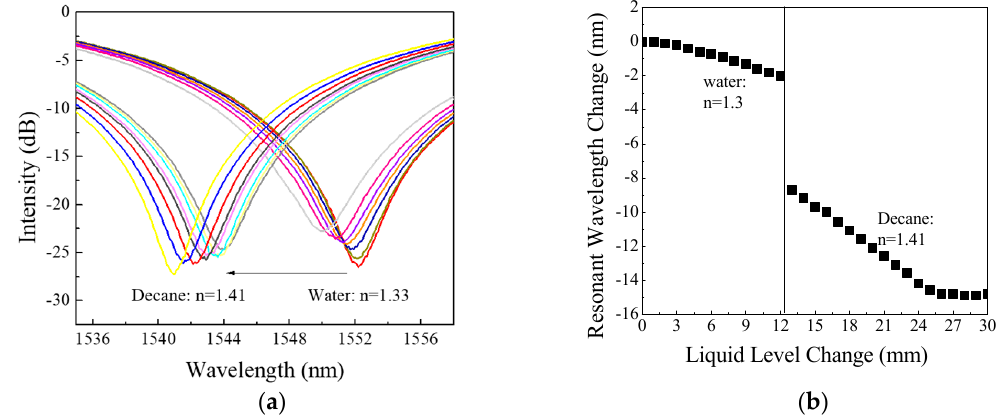
Figure 7. ( a ) Transmission spectrum; ( b ) Resonant wavelength changes of LP 07 vs. simultaneous liquid interface and level changes (water and decane).